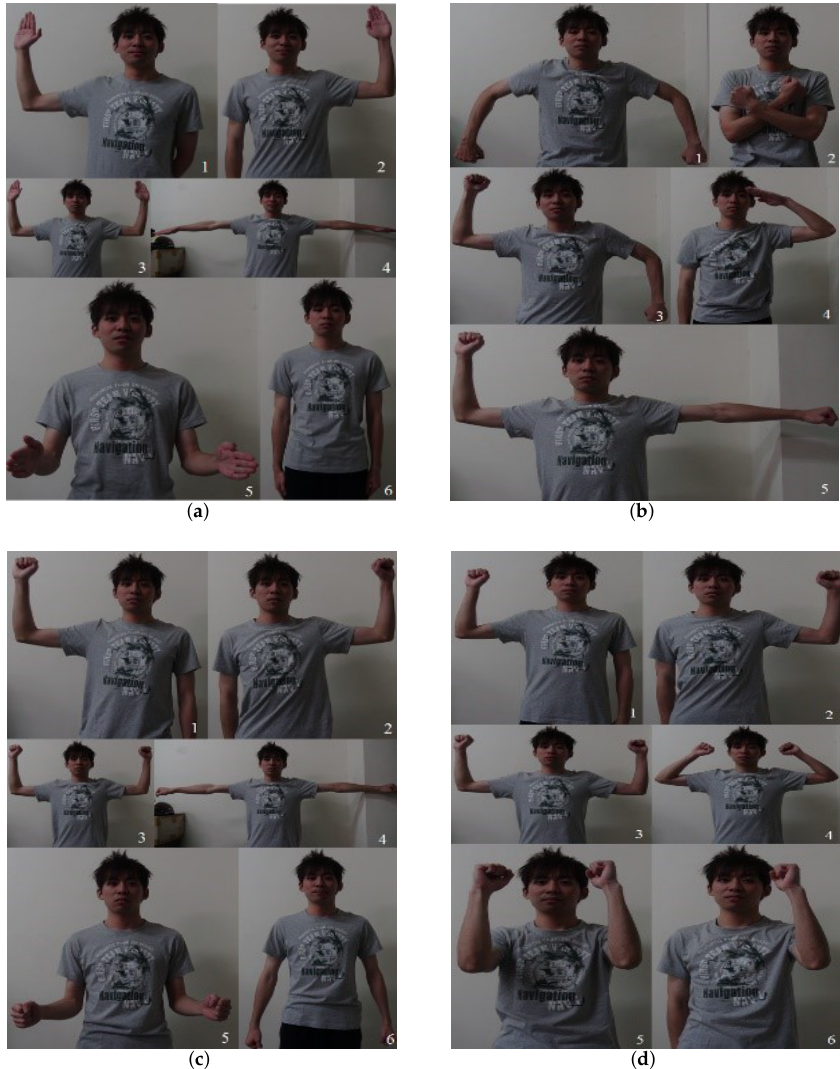
Figure 8. Action I ( a ), Action II ( b ), Action III ( c ) and Action IV ( d